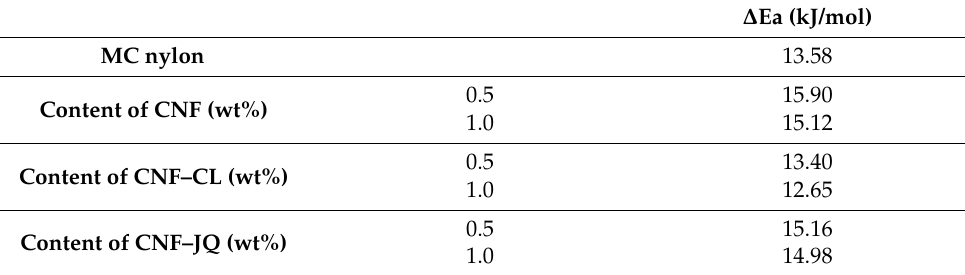
Figure 15. Curves of ln( Φ /T p2 ) versus 1/Tp for MC nylon and its composites (( a ) is the activation curve of CNF; ( b ) is the activation curve of CNF − CL; ( c ) is the activation curve of CNF − JQ). Table 5. Non isothermal activation energy parameters of MC nylon and MC nylon composites.